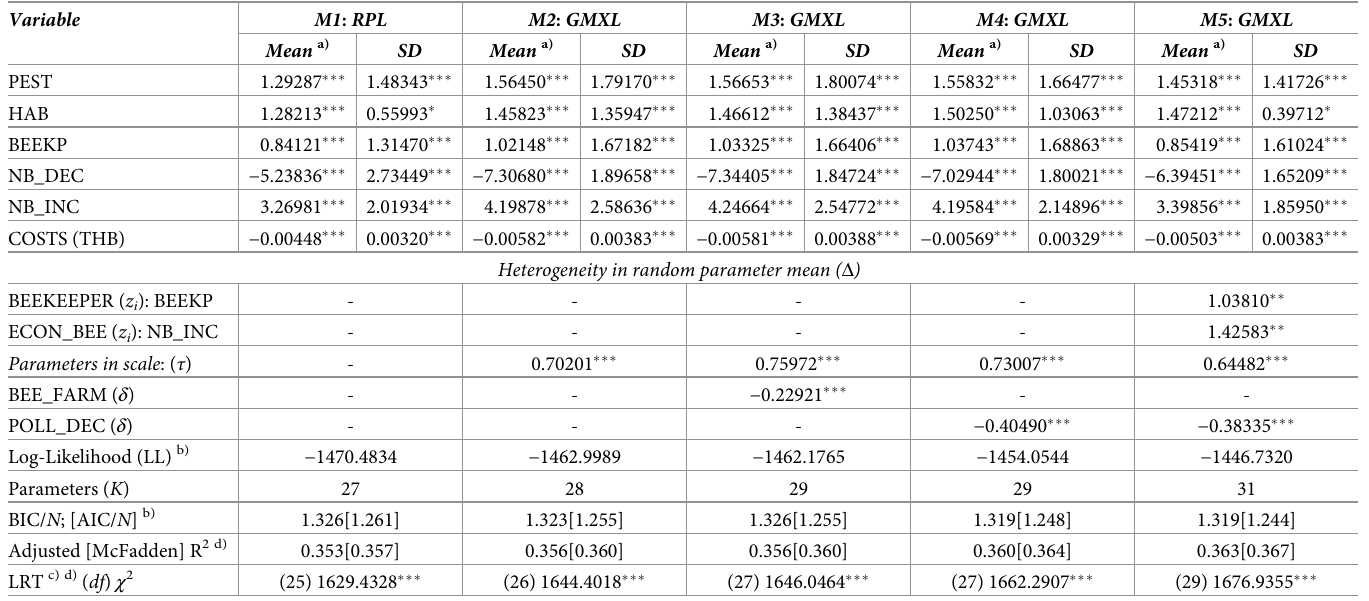
Refer to Table 1 for variable definitions. N = 2376 choice observations from 198 respondents.